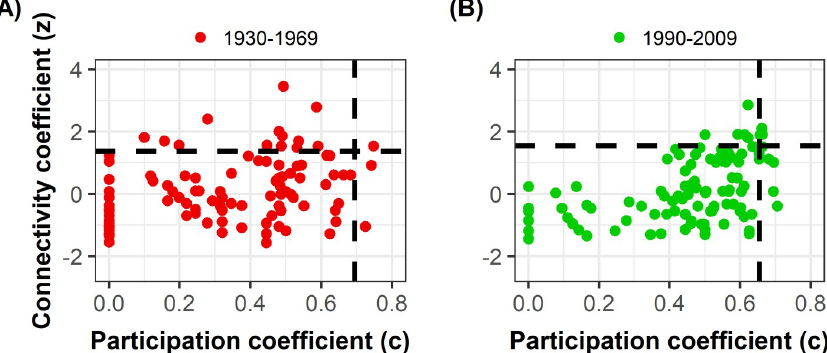
Fig 1. Biplot of connectivity coefficient of bee species ( z , ordinates) and their participation coefficient ( c , abscissa). (A) cz -values of bee species before 1970 and (B) after 1990. Vertical and horizontal dashed lines represent 90% quantiles of null model coefficients and delimit groups of species with different topological roles in networks [24,59,79].